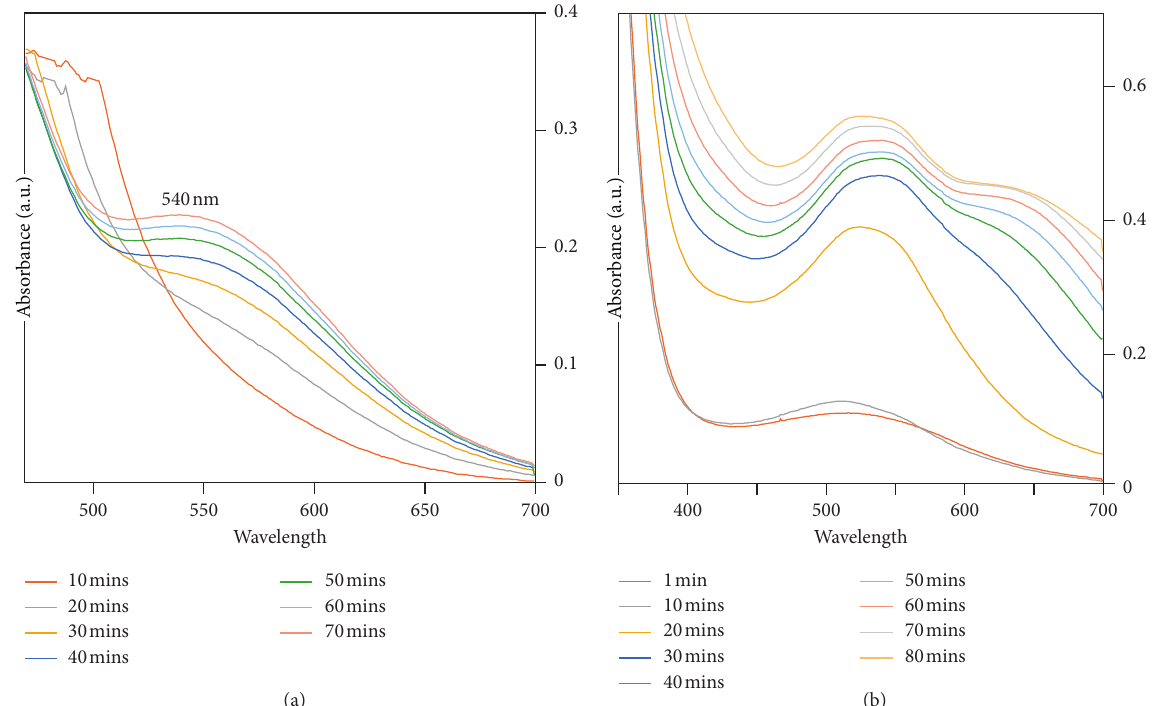
Figure 3: Time evolution of UV-vis absorption spectra of reaction mixture. (a) AuNPs at room temperature (b) AuNPs at 100 °